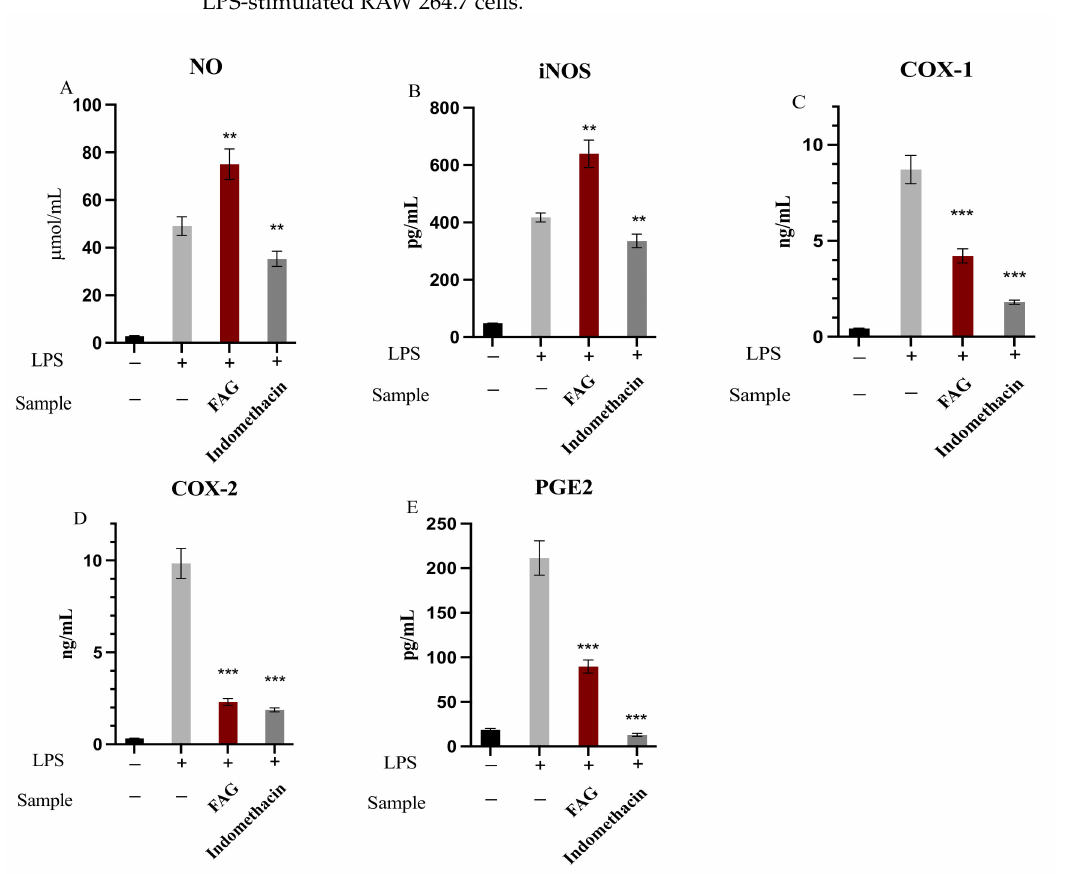
Figure 3. The effect of the FAG on NO concentration ( A ), iNOS enzyme activity ( B ), COX-1 enzyme activity ( C ), COX-2 enzyme activity ( D ), and PGE2 concentration ( E ) before and after treatment of LPS-stimulated RAW264.7 cells with the new FAG. Indomethacin was used as a positive control. Bars represent mean ± SD ( n = 3), **; p < 0.01, ***; p < 0.001, when compared to untreated LPS-stimulated RAW264.7